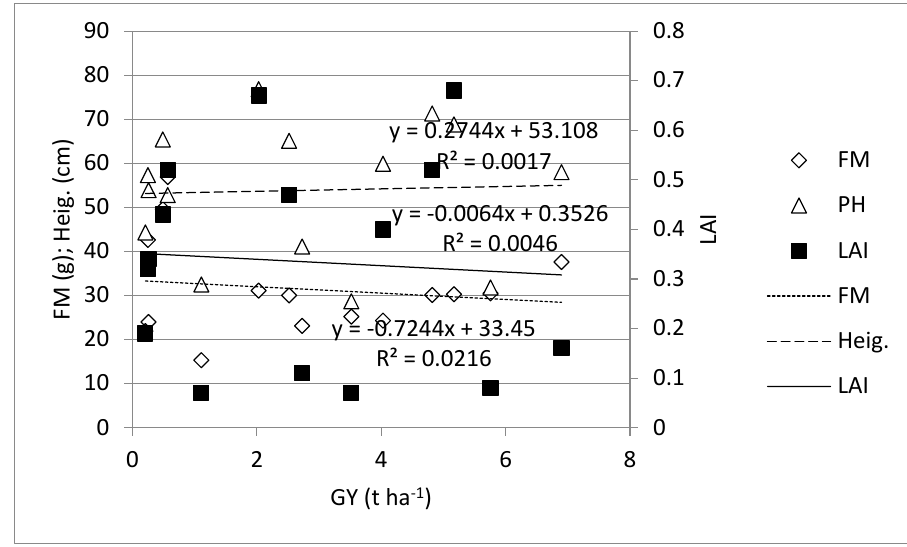
Figure 5. Correlation between grain yield (GY) and fresh matter (FM), plant height (Heig.) and leaf area index (LAI) 21 DAT in the control treatment (FAA). Agriculture 2020 , 10 , x FOR PEER REVIEW